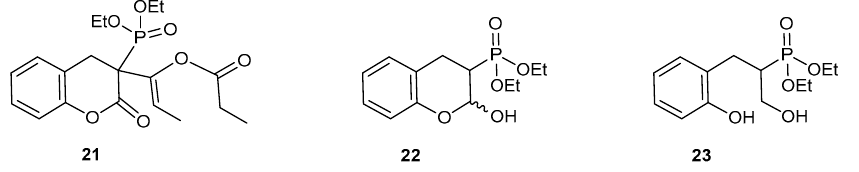
Figure 6. Products isolated from acylation reaction.